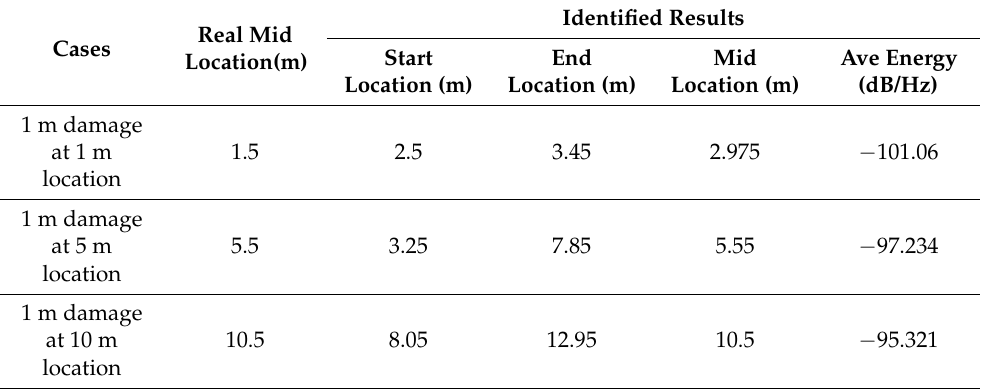
Table 2. Comparison of Short-Time Fourier Transform (STFT) results of different damage locations on the bridge.